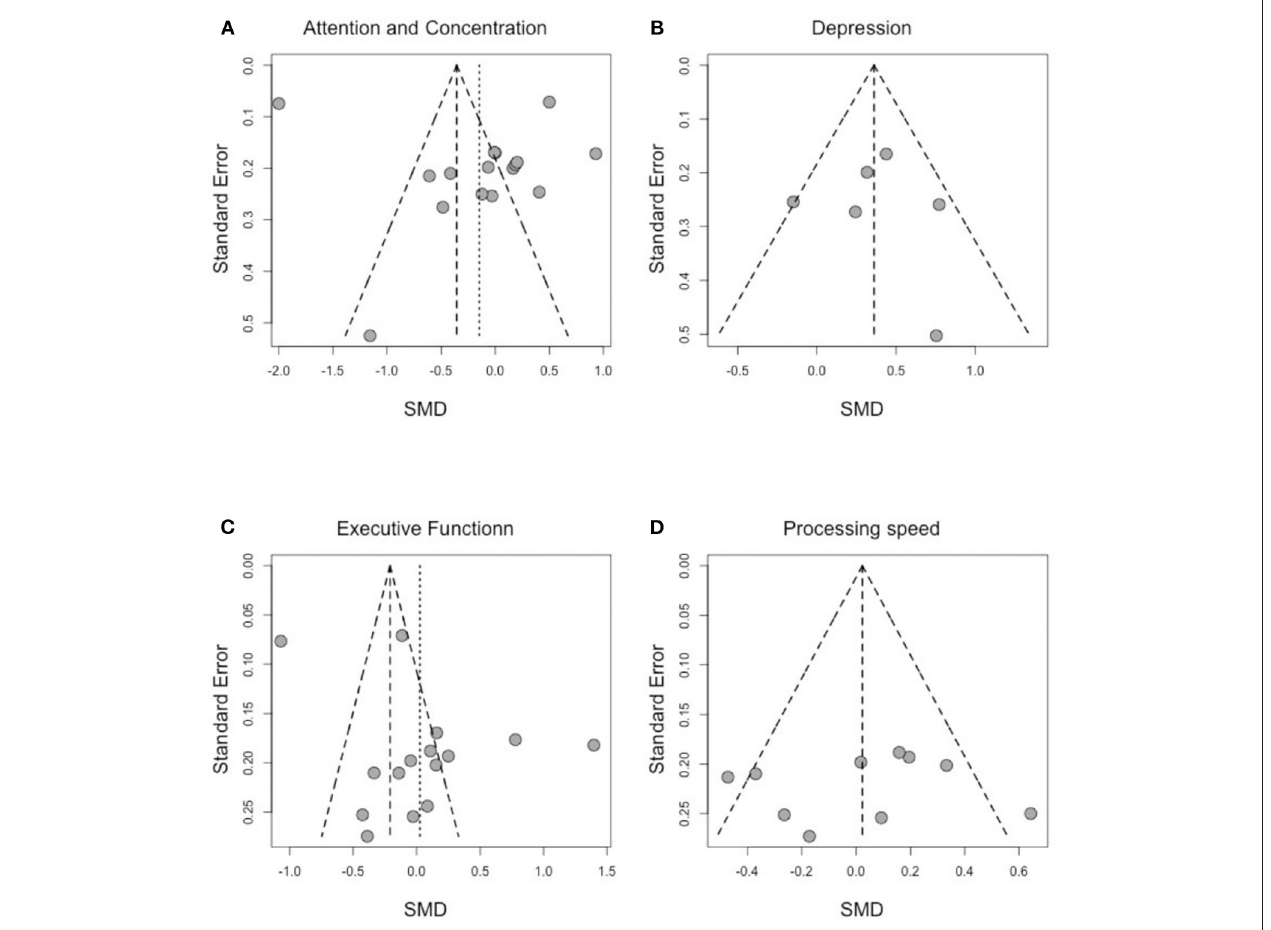
FIGURE 4 | Funnel plot of effect sizes by SE for (A) attention and concentration, (B) depression, (C) executive function, and (D) processing